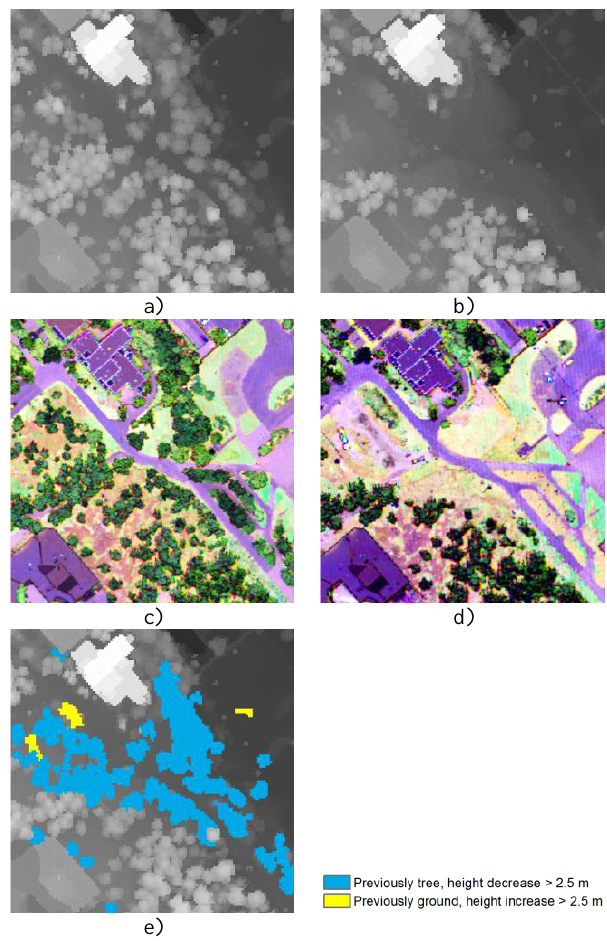
Figure 4. a) DSM from August 2015; b) DSM from June 2016; c) intensity image from August 2015; d) intensity image from June 2016; e) height changes detected in the